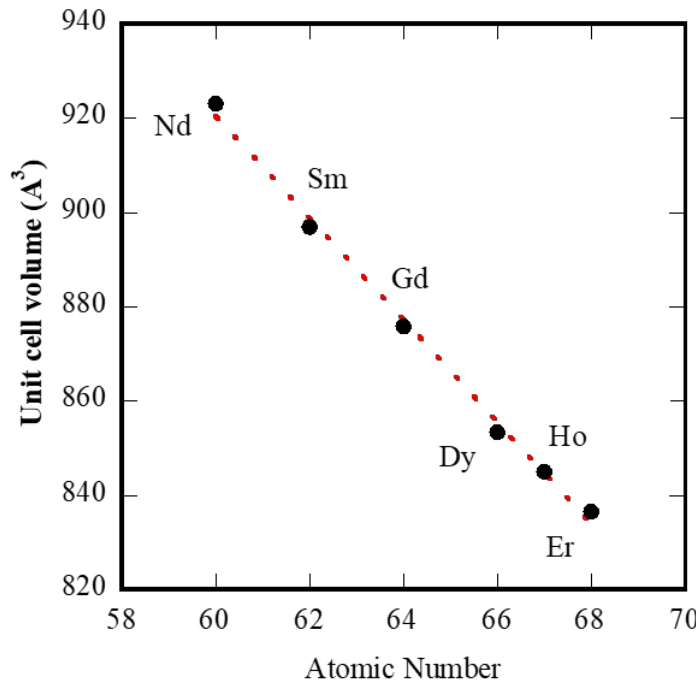
Figure 9. Unit cell volumes of lanthanide carbonates as a function of atomic number.